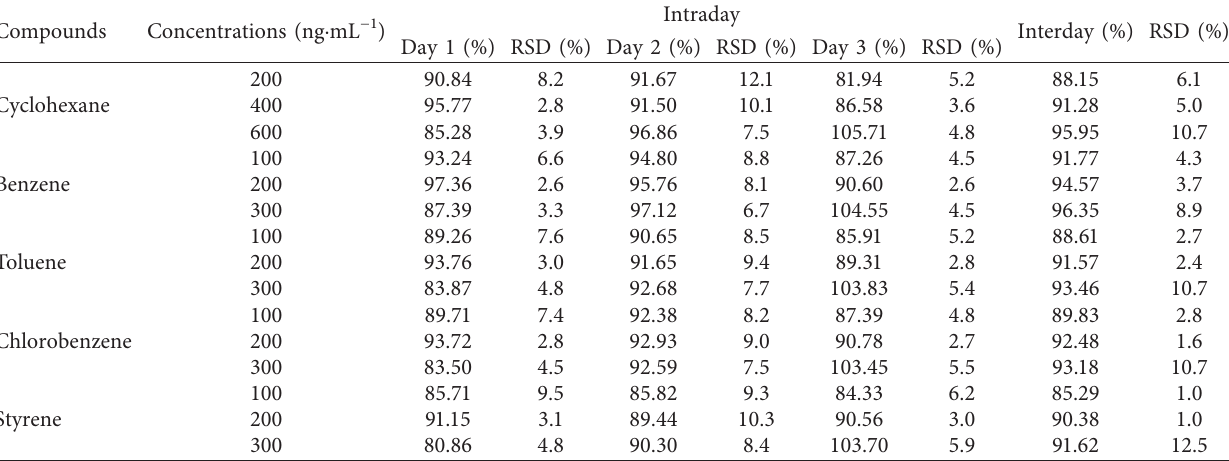
Table 3: Accuracy and precision of five volatile organic compounds.